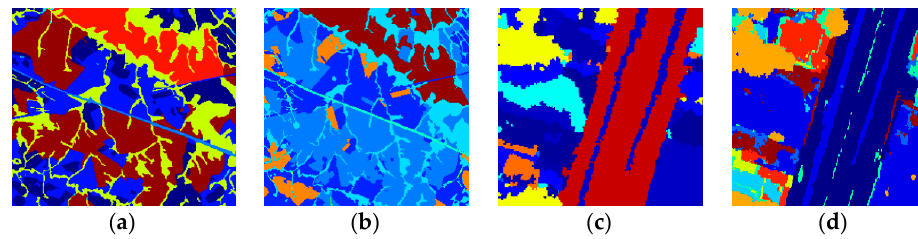
PAN (1 m), resulting in a final spatial resolution of 1 m. Ikonos-2 MS and Geoeye images were obtained through a fusion process between MS (4 m) and PAN